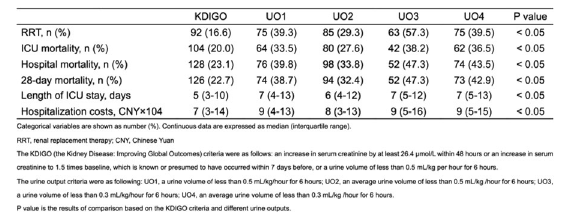
Table 1 (abstract 000570). Comparison of clinical outcomes based on the different criteria